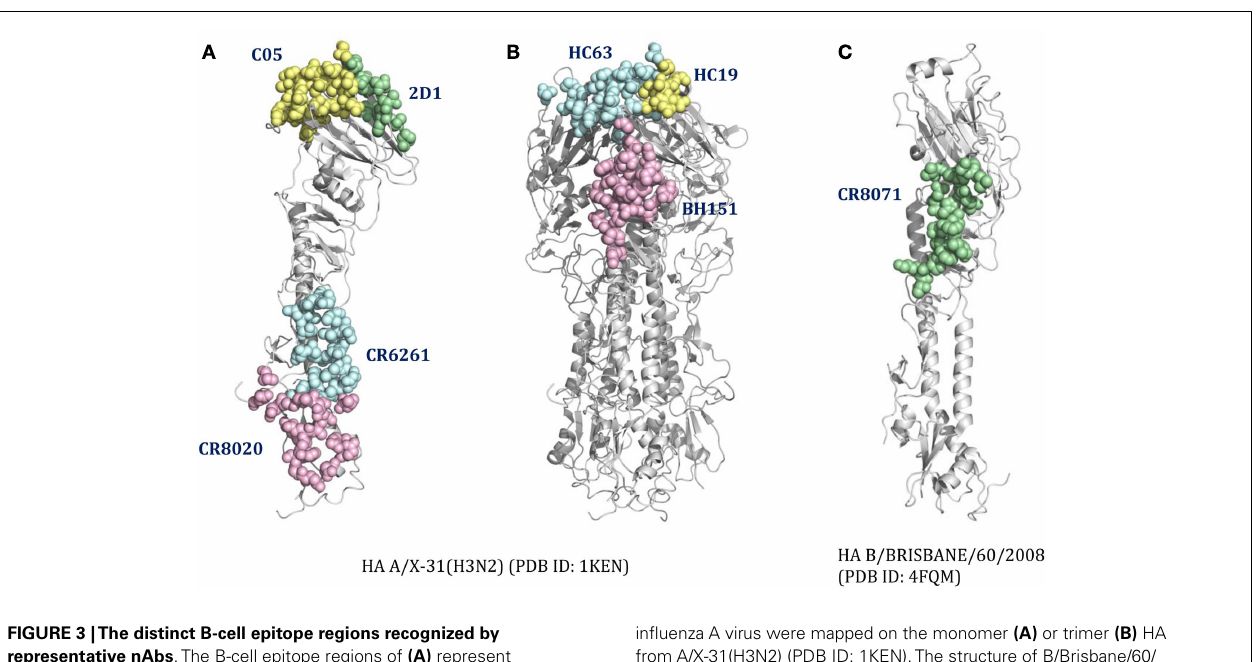
FIGURE 3 |The distinct B-cell epitope regions recognized by representative nAbs .The B-cell epitope regions of (A) represent cross-reactive nAbs against influenza A virus; (B) represent strain-specific nAbs against X-31(H3N2); (C) represent broadly nAb CR8071 against influenza B virus.The epitope regions of nAbs target